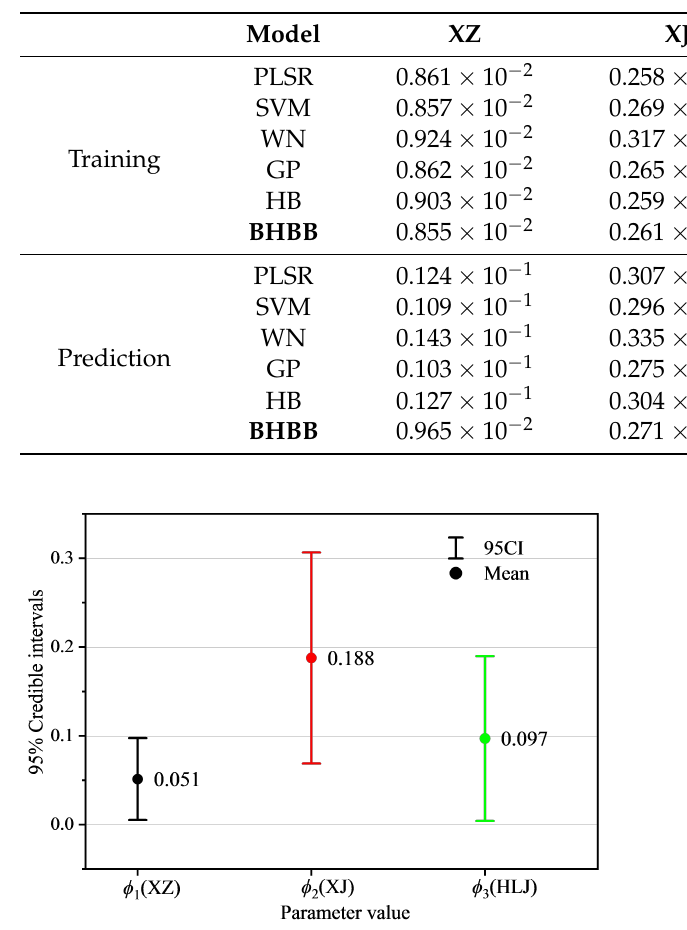
Figure 7. The confidence interval of φ i for outlier identification structure in BHBB.